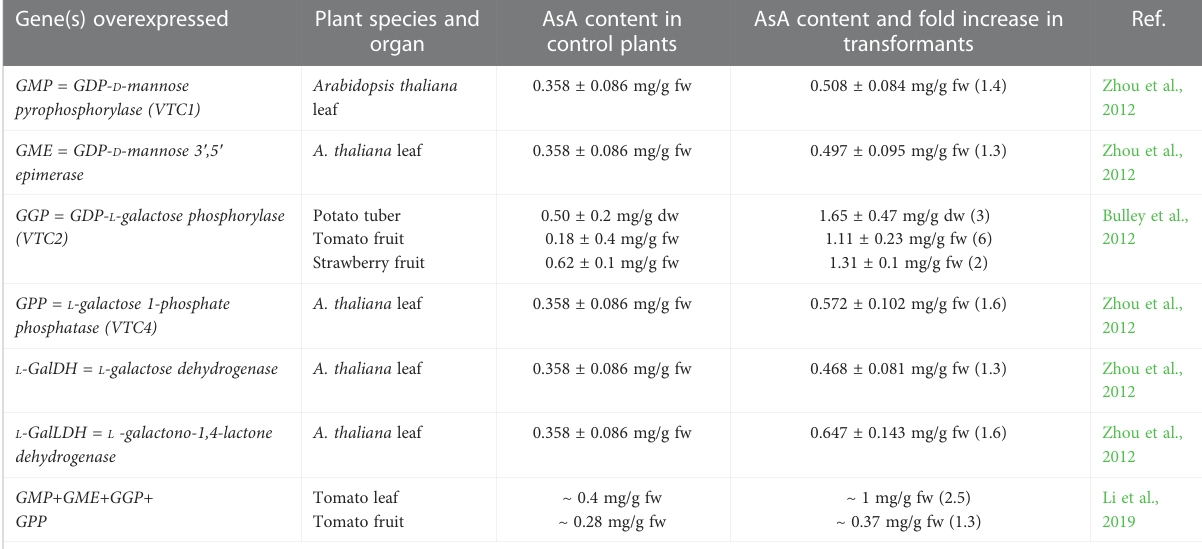
TABLE 2 Effect of the overexpression of selected genes of the main ascorbic acid (AsA) biosynthetic pathway on AsA content. Gene(s) overexpressed Plant species and AsA content and fold increase in organ control plants transformants